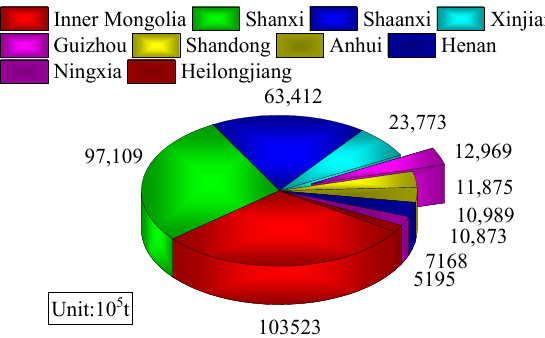
Figure 1. Distribution of China’s coal production in 2019.